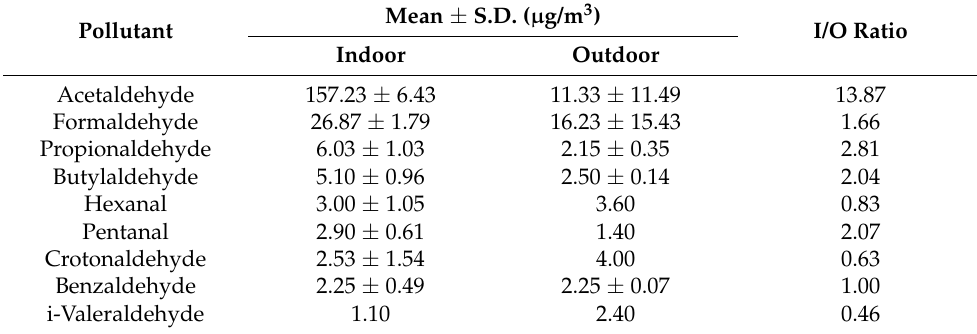
Table 6. Aldehyde concentrations in the valuable archive. I/O ratio—indoor/outdoor ratio.